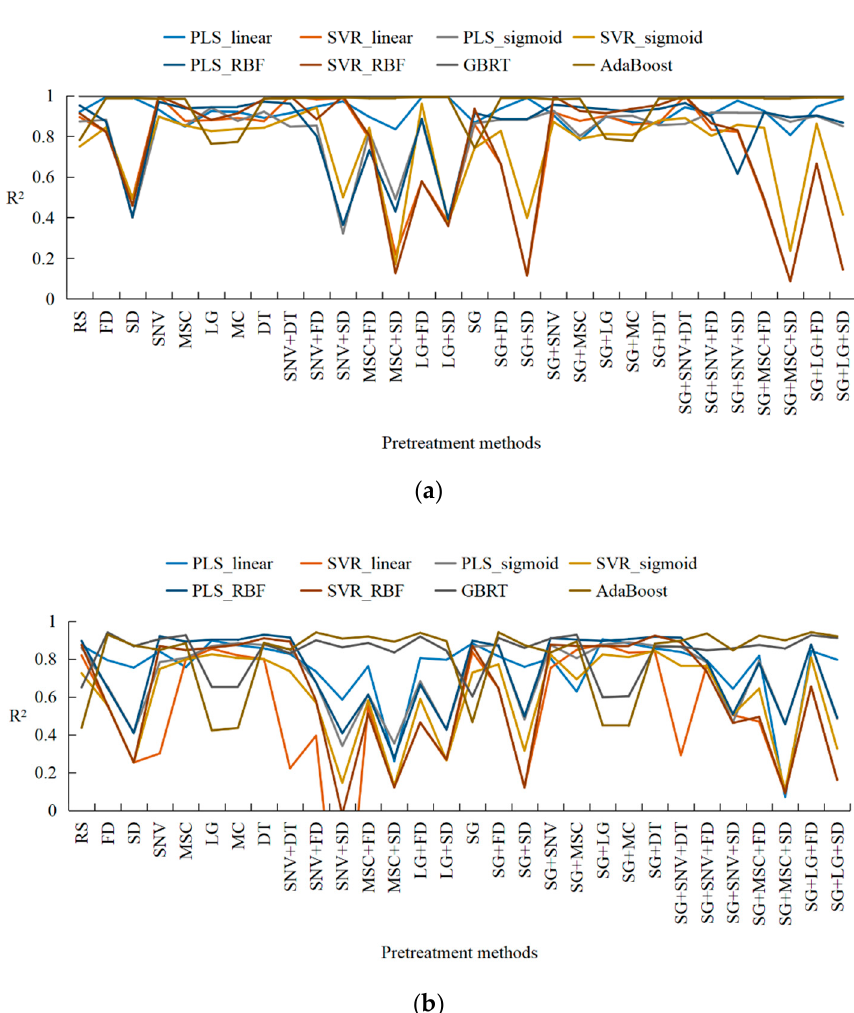
Figure 4. The accuracy of regression models with training ( a ) and testing ( b ) datasets by all pretreatment methods. Table 4. RPD level of regression models with different pretreatment methods.